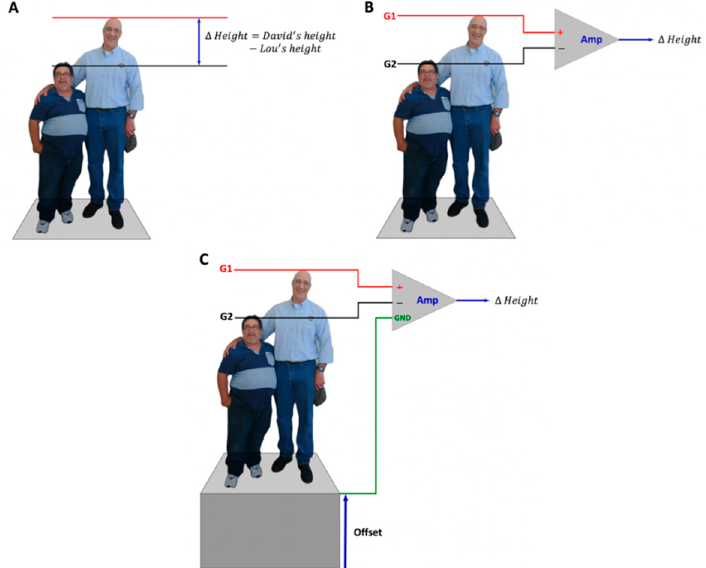
Figure 1. The differential amplification of height. ( A ) David’s height is indicated by the red (+) line and Lou’s height is indicated by the black line ( − ). ( B ) The height indicators are now depicted as electrode leads with G1 and G2 inputs to the operational amplifier, which sums the two heights as described in panel ( A ). The resulting output is the height difference. ( C ) The ground is now introduced to account for an “offset” where the height comparison is made above ground.